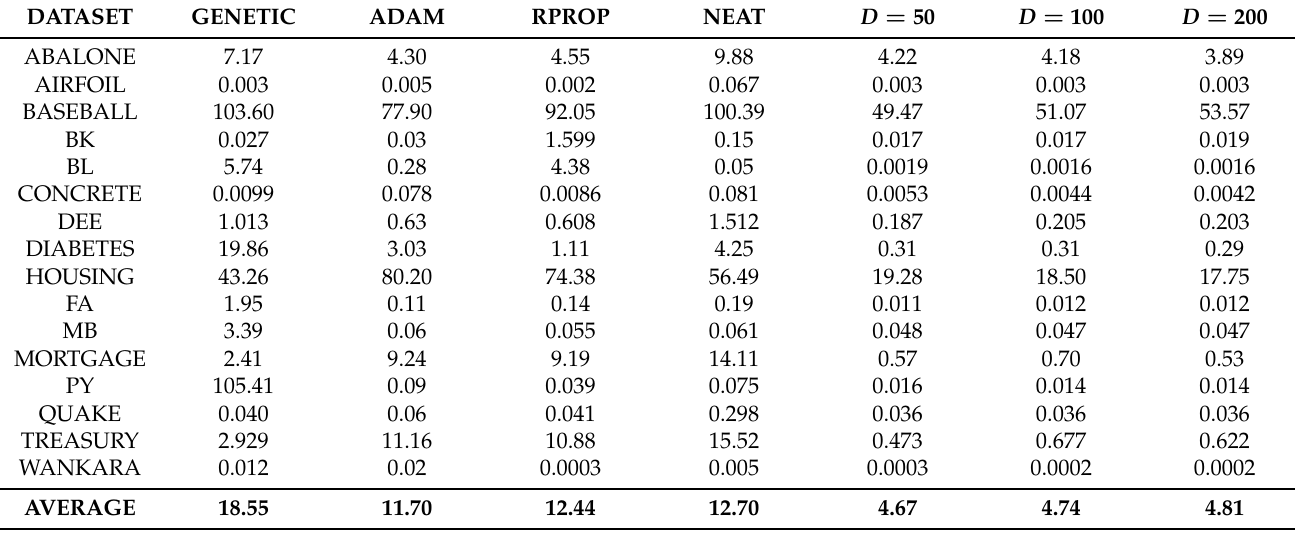
Table 3. Experiments for regression